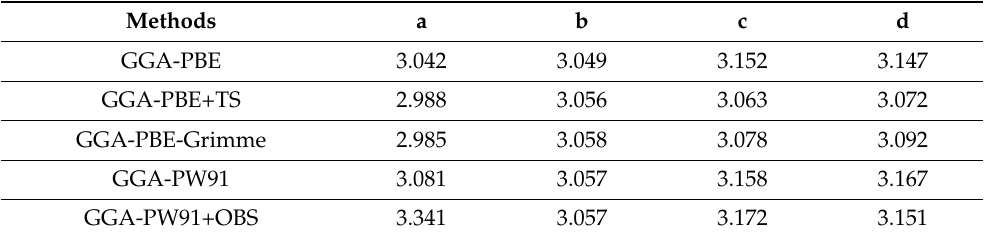
Table 5. Calculated optical gap energies of the different studied compound using DFT and DFT+D.